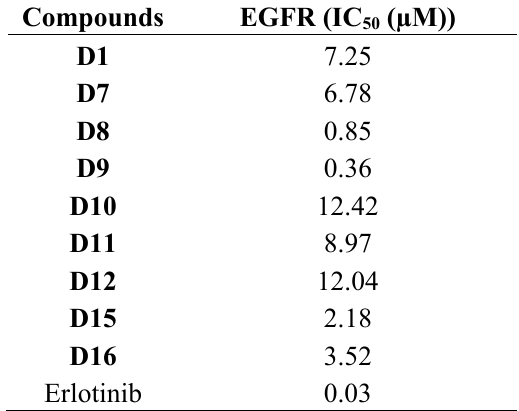
Table 3. EGFR inhibitory activity of synthetic compounds (after enzyme incubation with compounds for 70 min).